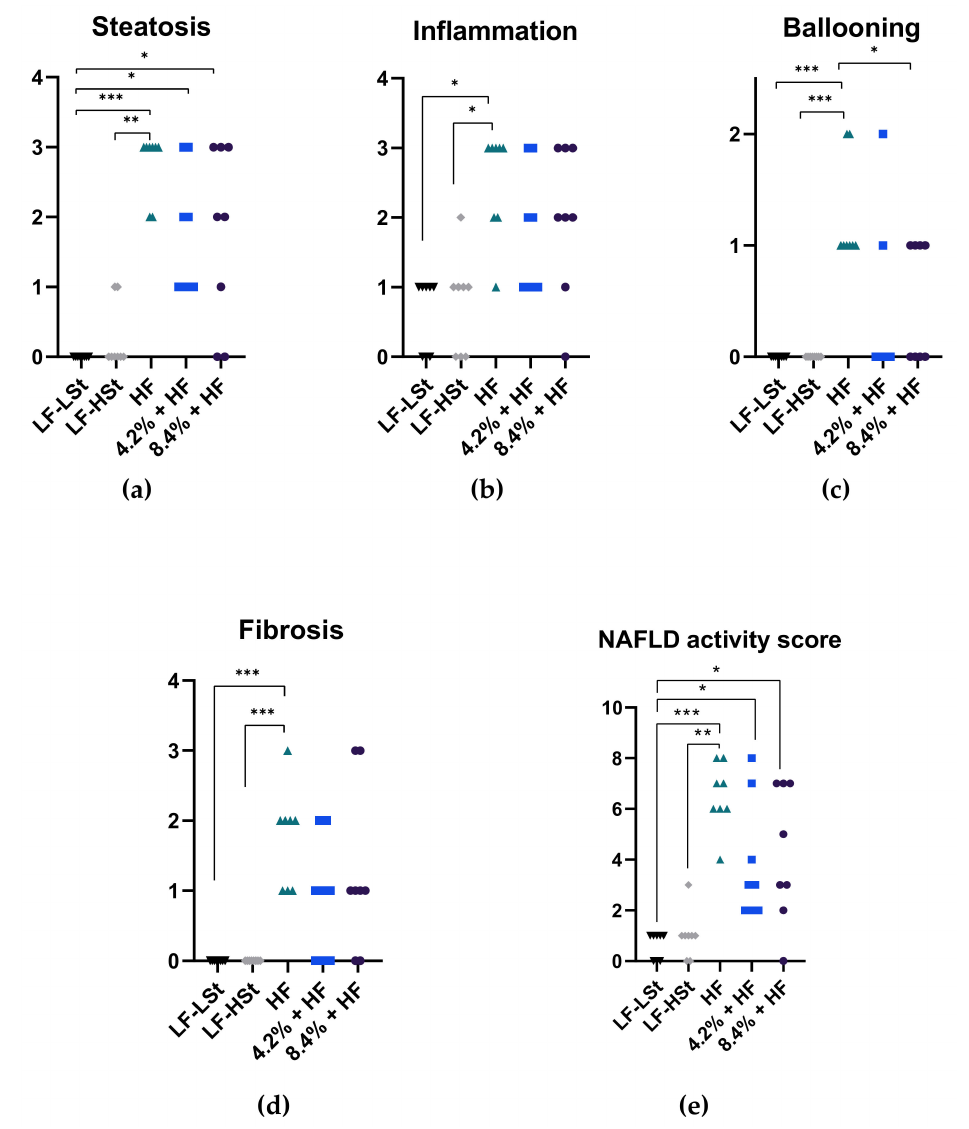
Figure 3. Histopathological scoring. Data are represented as individual scores with medians. ( a ) Steatosis scores for all groups on a scale of 0–3 ( b ) Inflammation scores for all groups on a scale of 0–3 ( c ) Ballooning scores for all groups on a scale of 0–2 ( d ) Fibrosis scores for all groups on a scale of 0–3 ( e ) Cumulative NAFLD activity score on a scale of 0–8. Scoring was performed as previously described [28]. The data was analyzed using a non-parametric Kruskal–Wallis with a Dunn’s multiple comparisons test. * p < 0.05, ** p < 0.01, *** p < 0.001. n = 8. LF: Low Fat, HSt: High Starch, LSt: Low Starch, HF: High